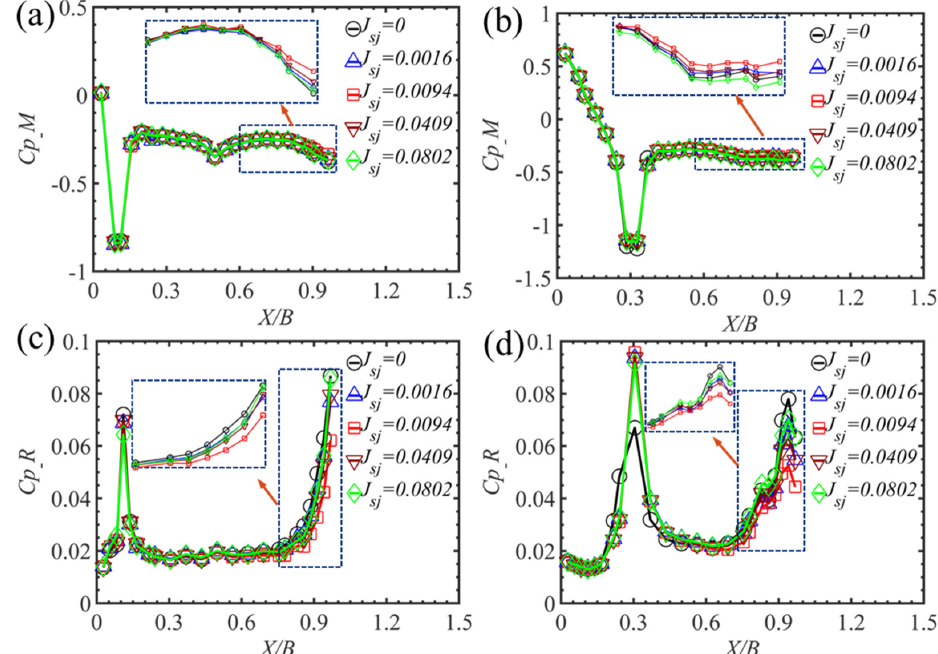
Figure 4. The external surface pressure distributing on the test model with and without the trailing edge jets. The mean of the upper surface ( a ) and lower surface ( b ) pressure distributions, RMS of the upper surface ( c ), and lower surface ( d ) pressure distributions.